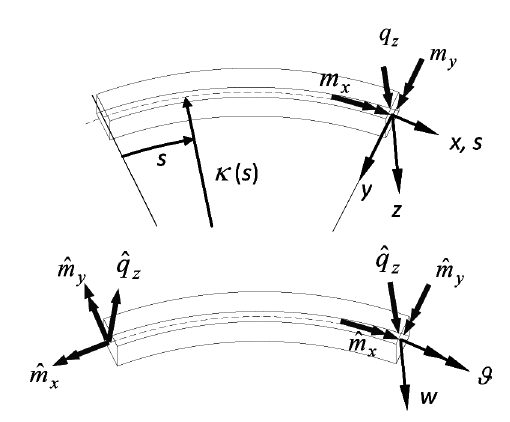
Fig. 2. Local coordinate system, external forces, displacements and internal